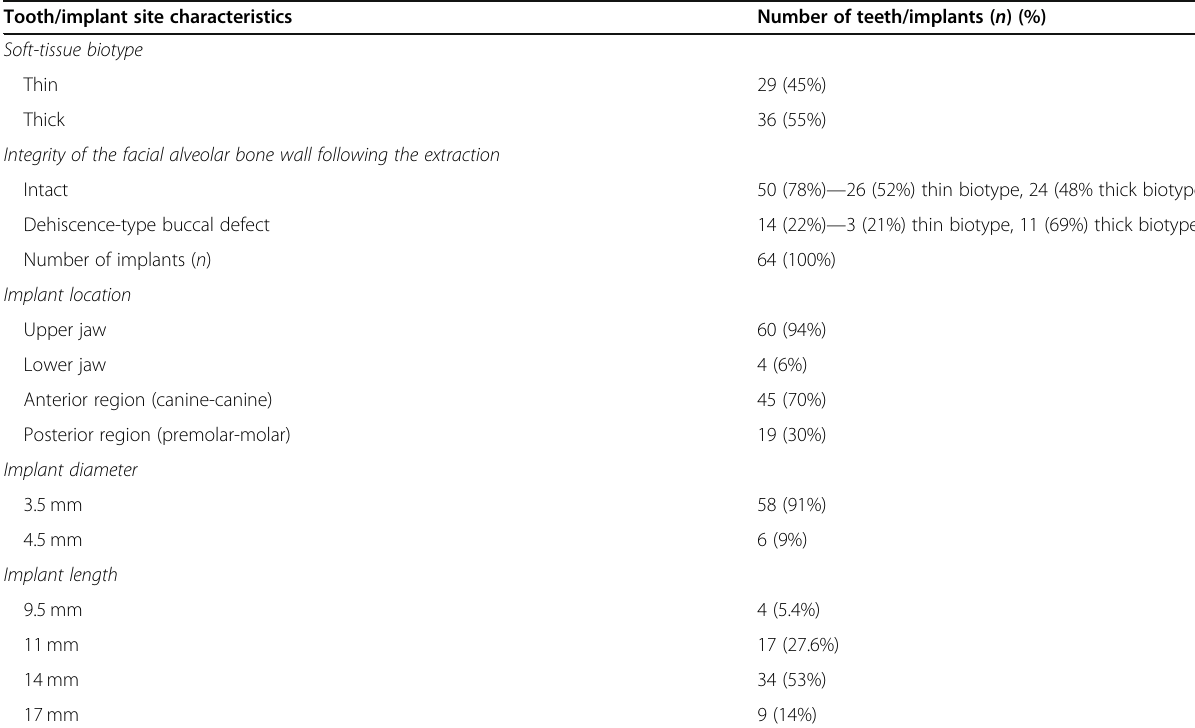
Table 2 Tooth/implant site characteristics Tooth/implant site characteristics Soft-tissue